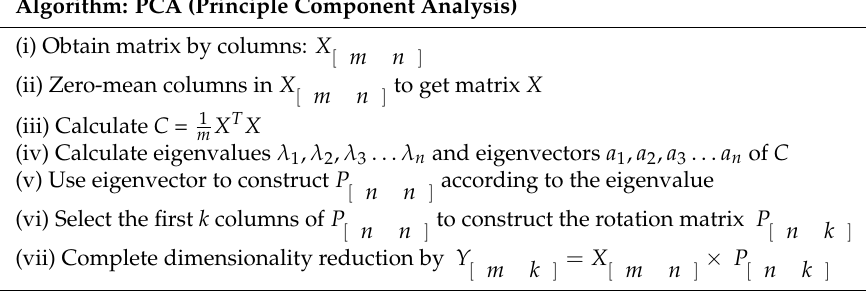
Algorithm: PCA (Principle Component